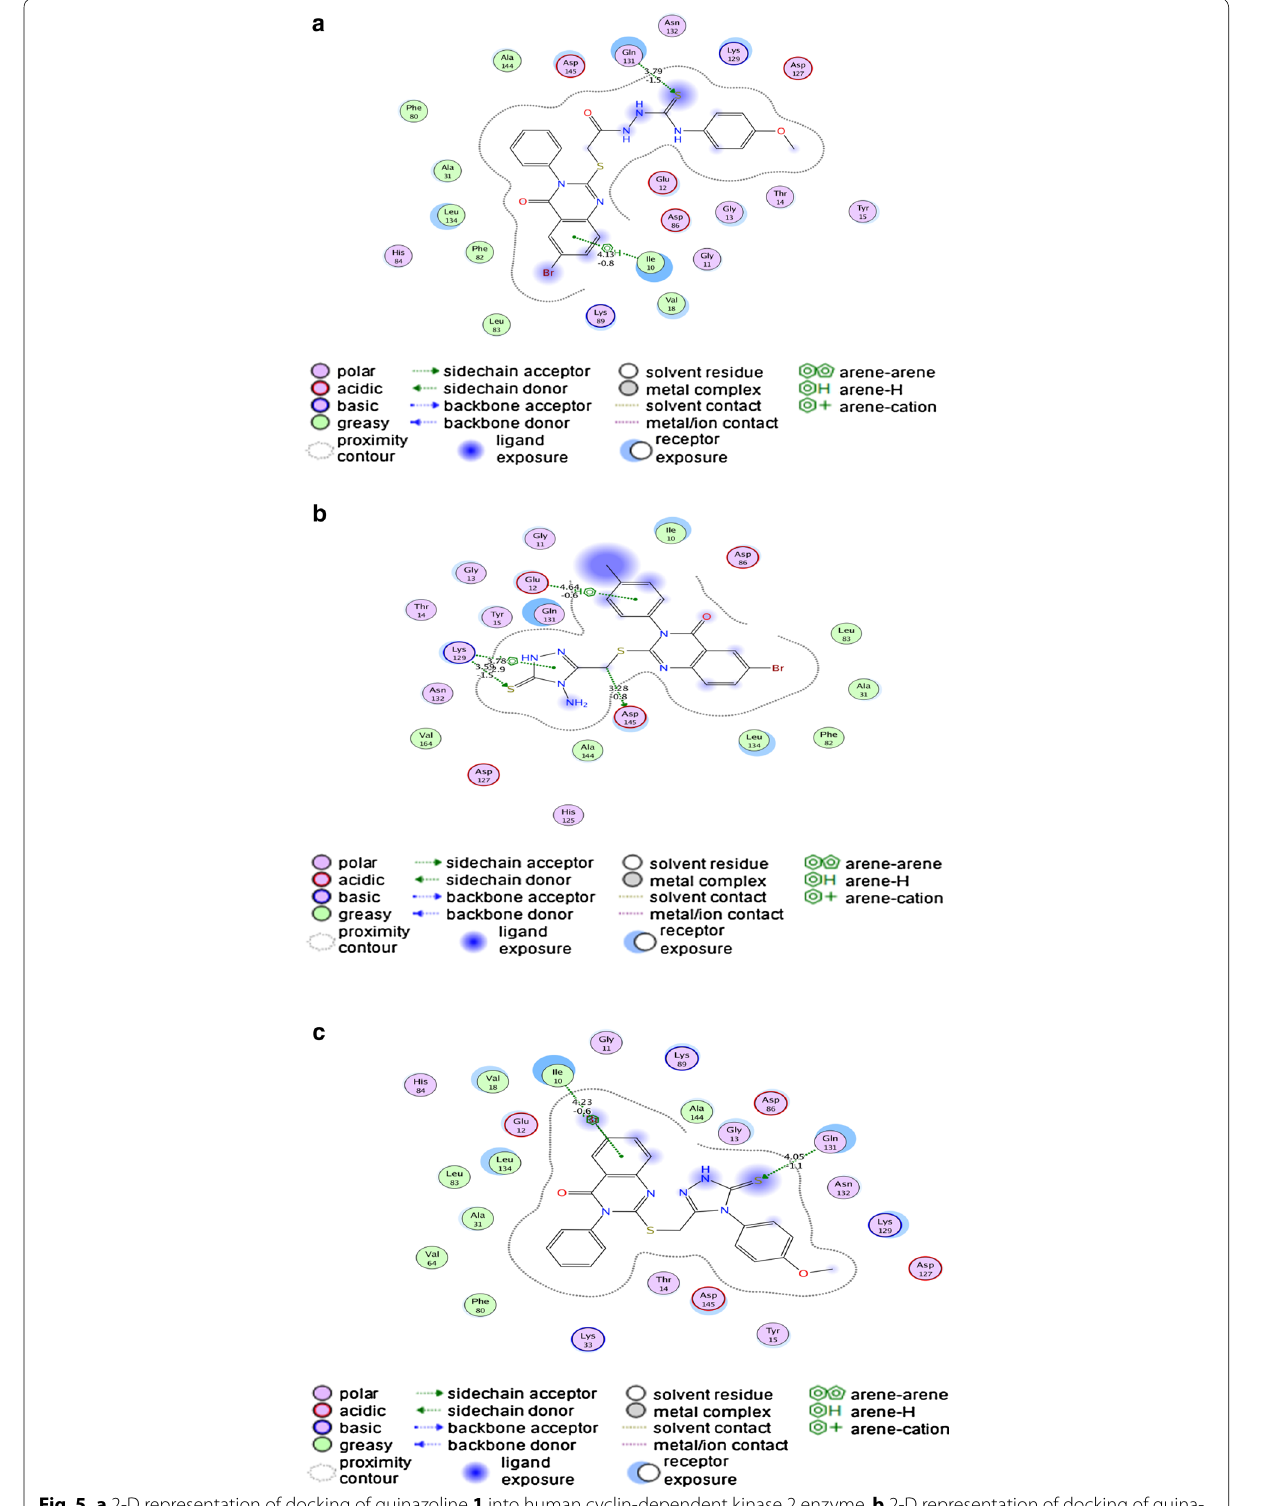
Fig. 5 a 2‑D representation of docking of quinazoline 1 into human cyclin‑dependent kinase 2 enzyme. b 2‑D representation of docking of quina‑ zoline 2 into human cyclin‑dependent kinase 2 enzyme. c 2‑D representation of docking of quinazoline 3 into human cyclin dependent kinase 2